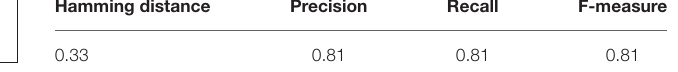
TABLE 1 | Segmentation accuracy of CMU motion capture data.